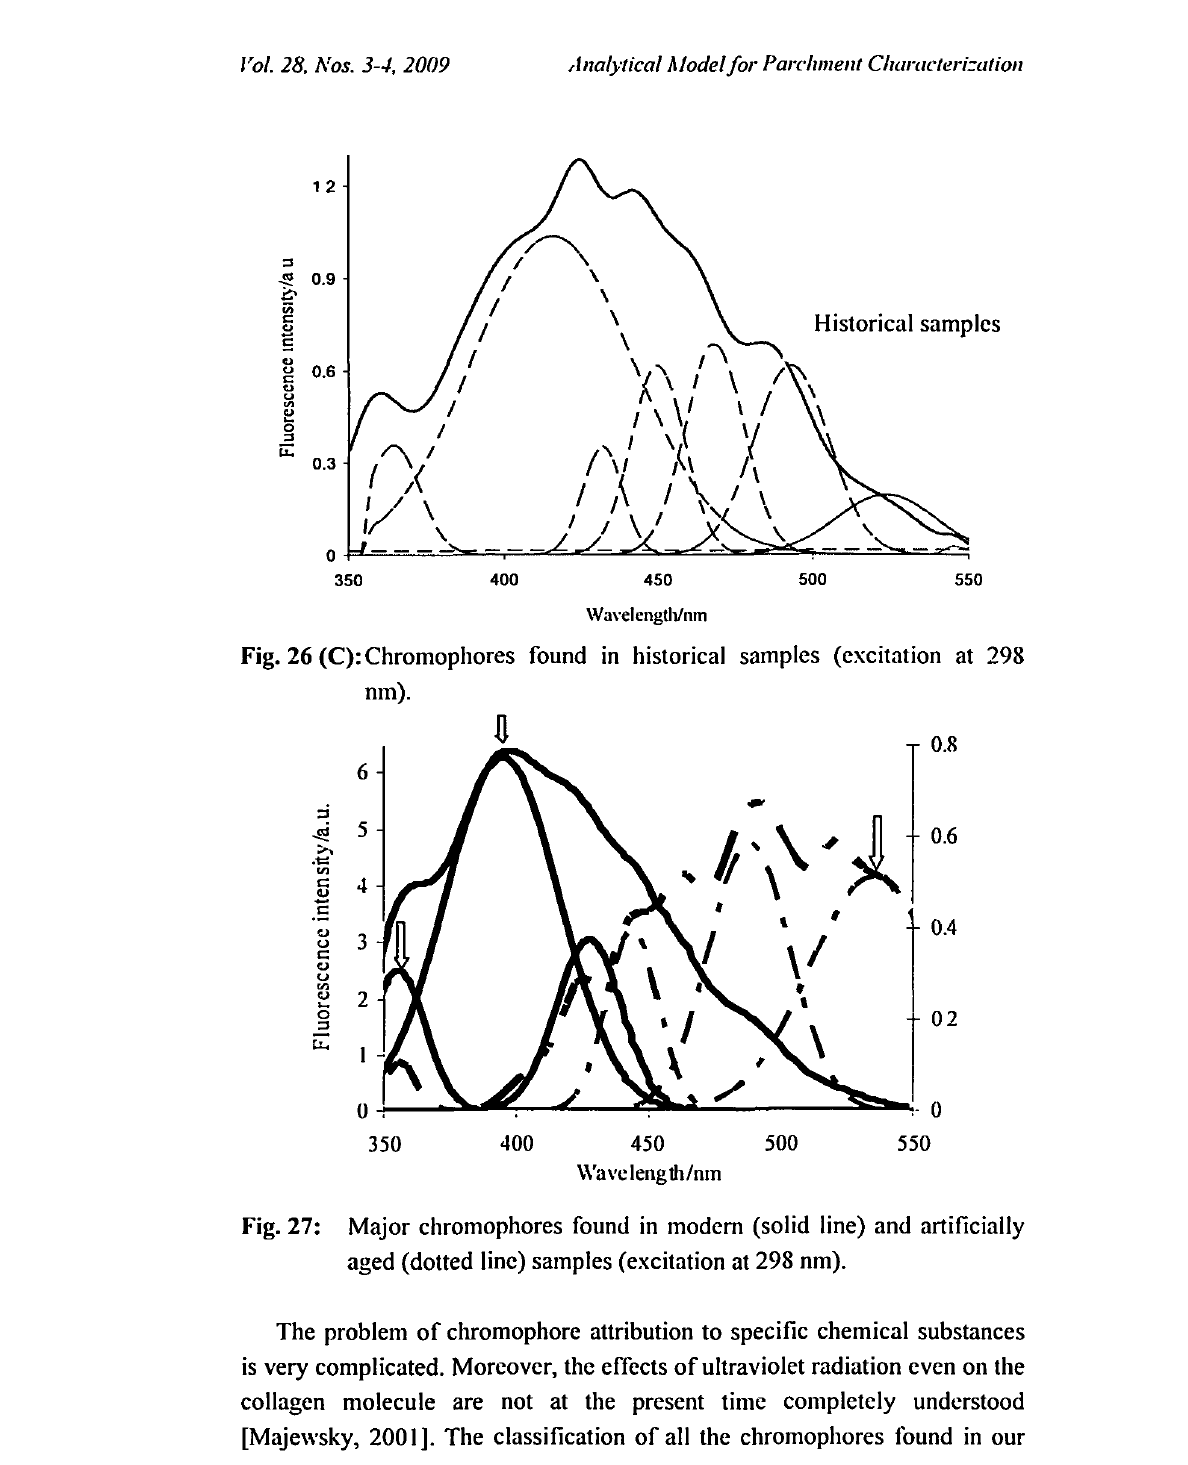
Fig. 27: Major chromophores found in modern (solid line) and artificially aged (dotted line) samples (excitation at 298